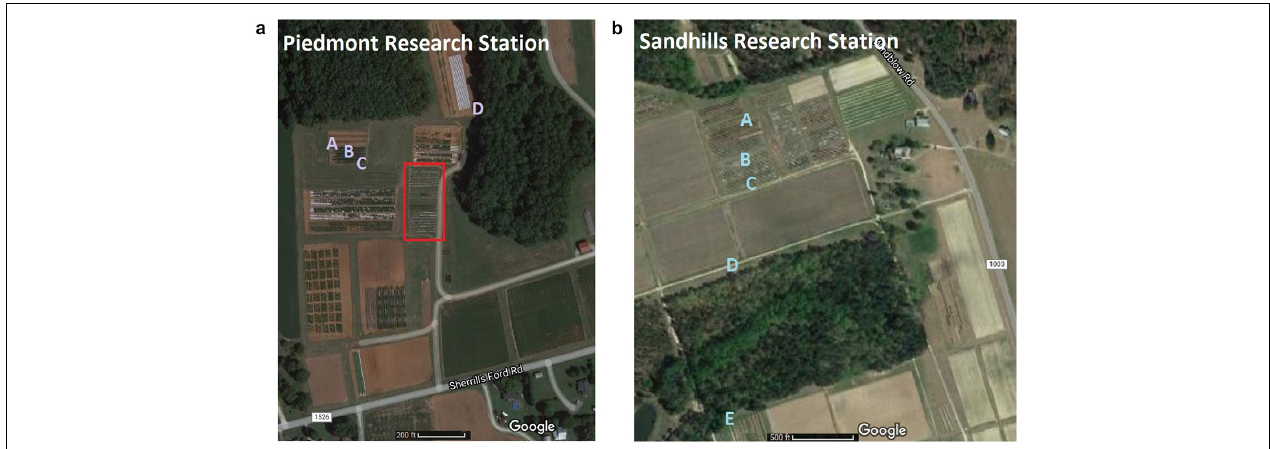
FIGURE 1 | (a) Piedmont Research Station blackberry plots. Traps A, B, and C, are at the edge, center, and edge, respectively, of a Von and Ouachita blackberry plot. Trap D represents the wooded edge. Note that in the outlined square are caneberry breeding plots with blackberry, raspberry, black raspberry, golden raspberry, and other caneberries present at the same time. Coordinates are 35 ◦ 41 (cid:48) 49 (cid:48)(cid:48) N 80 ◦ 37 (cid:48) 45 (cid:48)(cid:48) W (Google, 2021a). (b) Sandhills Research Station blueberry plots. Traps A, B, and C were placed in a rabbiteye blueberry germplasm plot. The early-season blueberry plots in the two fields to the right were no longer fruiting during this experiment. Trap D is on a near wooded edge, and E represents a distant wooded edge. Coordinates are 35 ◦ 11 (cid:48) 39 (cid:48)(cid:48) N 79 ◦ 41 (cid:48) 06 (cid:48)(cid:48) W (Google,